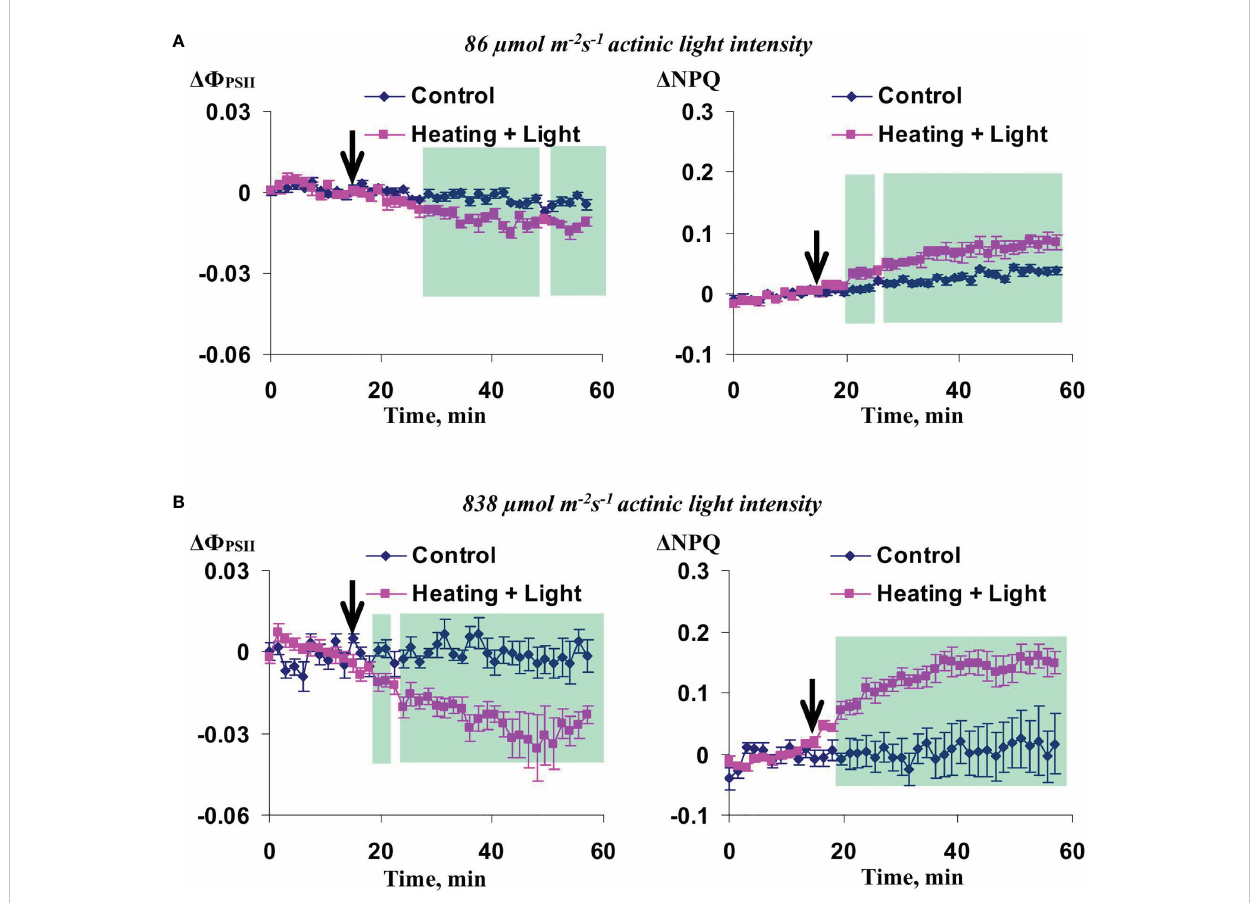
FIGURE 4 Averaged changes in the quantum yield of photosystem II ( D Ф PSII ) and non-photochemical quenching of chlorophyll ( D NPQ) in 3 cm from zone of the local action of combination of heating and blue light in wheat plants under 86 µmol m -2 s -1 (A) and 838 µmol m -2 s -1 (B) intensity of the white actinic light ( n =8). Arrow marks initiation of this action; control plants were not irritated. Green shadings show time intervals with signi fi cant differences between experimental and control values ( p <0.05, Student ’ s